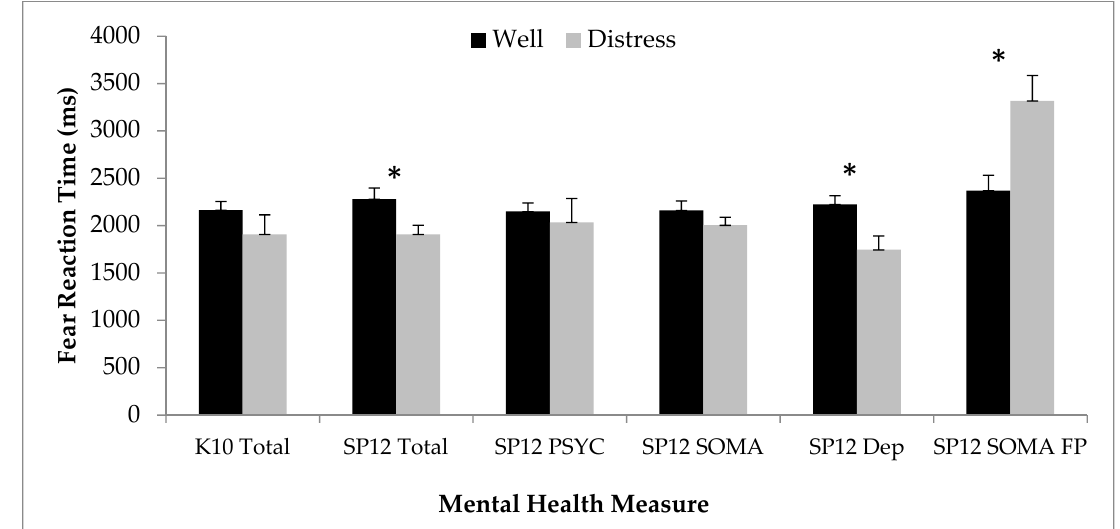
Figure 2. Fear Faces: bar graph showing differences in reaction times for recognition of fear affect or false positives for fear for psychologically well participants (black bars) vs. those with a possible mental disorder (grey bars). An asterisk above the bars denotes a significant difference ( p < 0.05).